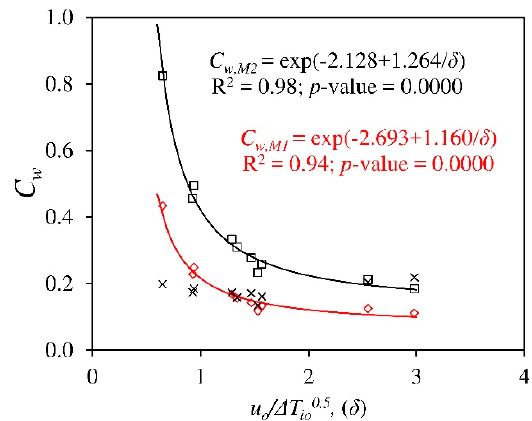
Figure 7. Greenhouse wind effect coefficient C w , obtained for each test, expressed as a function of the ratio u o / ∆ T io0.5 or δ (b): ◊ , C w-M1 ; □ , C w-M2 ; ×, C w-M3 .